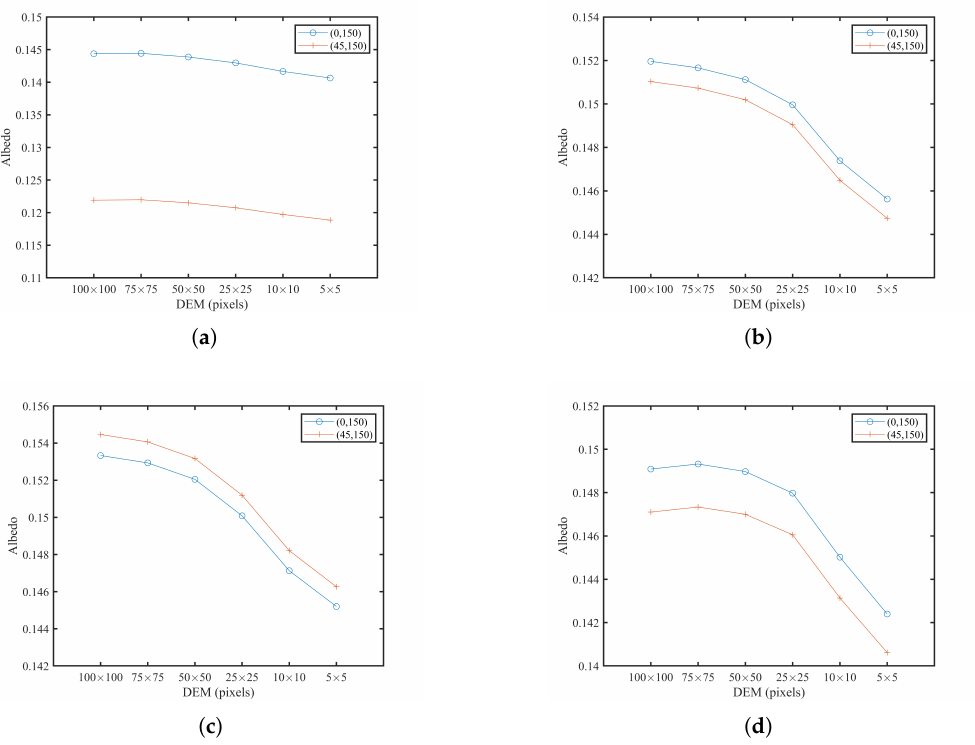
Figure 9. Albedo of four lunar surface regions at different scales: ( a ) Area A, ( b ) Area B, ( c ) Area C, and ( d ) Area D. The ordinate coordinates of the four groups of albedo figures are not unified.